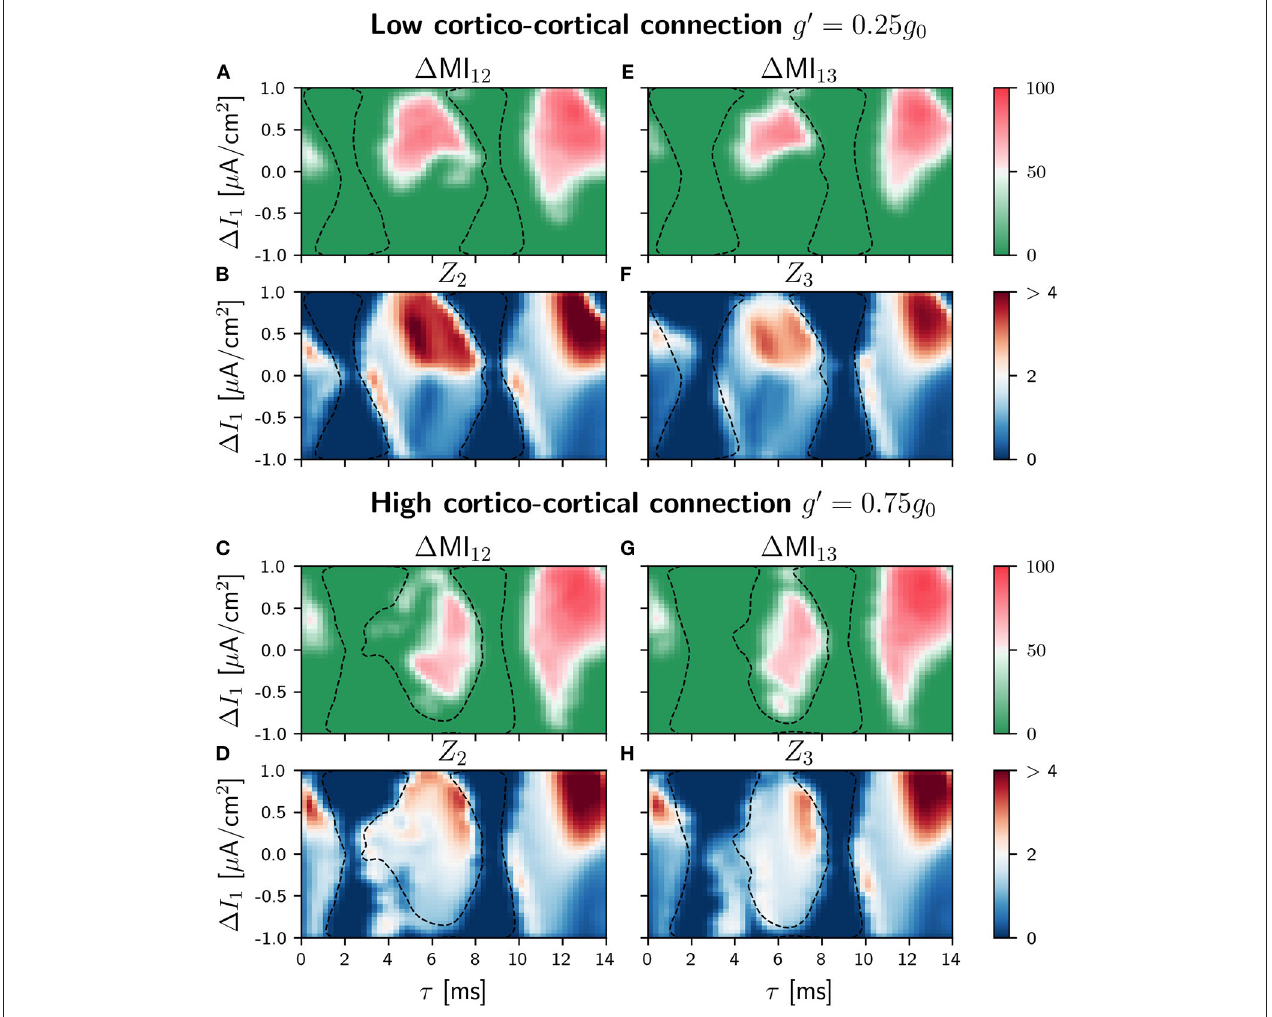
0.25 g 0 (A and E) and g ′ 0.75 g 0 (C and G) when a slow modulation is injected. Integral = = 0.25 g 0 (B and F) and g ′ 0.75 g 0 (D and H) when a fast signal is injected. All of them as a function of the delay τ and the = =